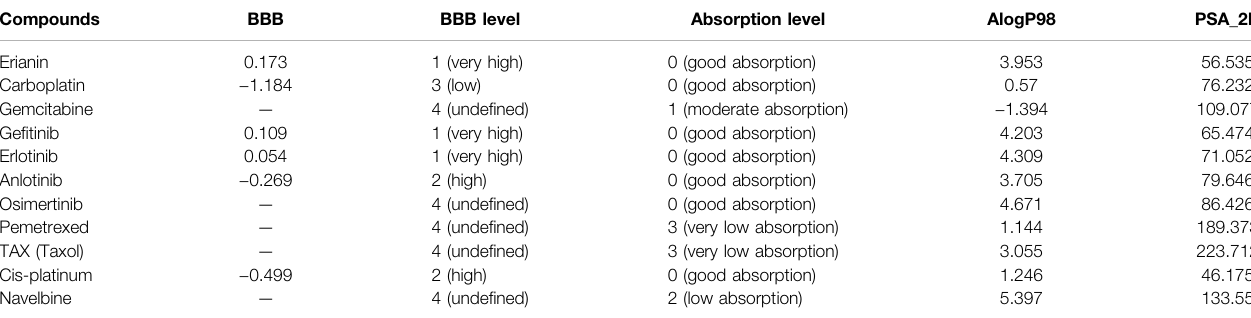
TABLE 2 | Blood – brain barrier penetration and human intestinal absorption prediction of erianin and reference drugs. Compounds BBB Erianin